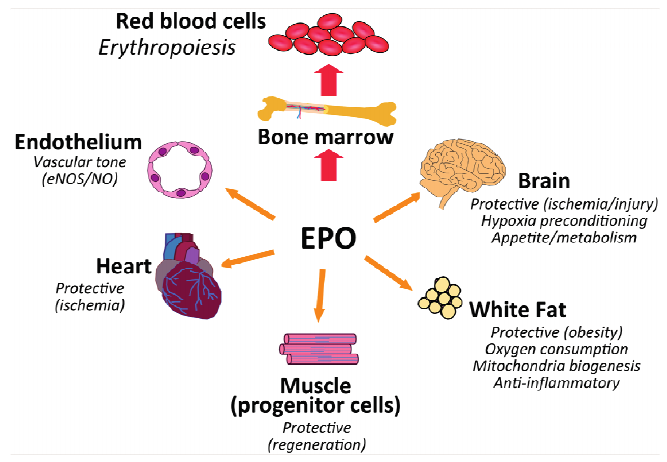
Figure 6. Pleiotropic effects of EPO. EPO is a multi-functional cytokine with the primary activity to regulate red blood cell production in the bone marrow. EpoR, expressed at the highest level in erythroid progenitor cells, is also expressed in select non-hematopoietic tissues that provides for EPO response. Non-hematopoietic expression of EpoR and the potential consequence of EPO activity gleaned from model systems include vascular endothelium to stimulate NO production to regulate vascular tone, heart to provide protection against ischemic injury, skeletal muscle myoblasts to promote wound healing, white adipose tissue for metabolic regulation and protect against diet induced obesity, and brain for metabolic regulation and to provide protection against